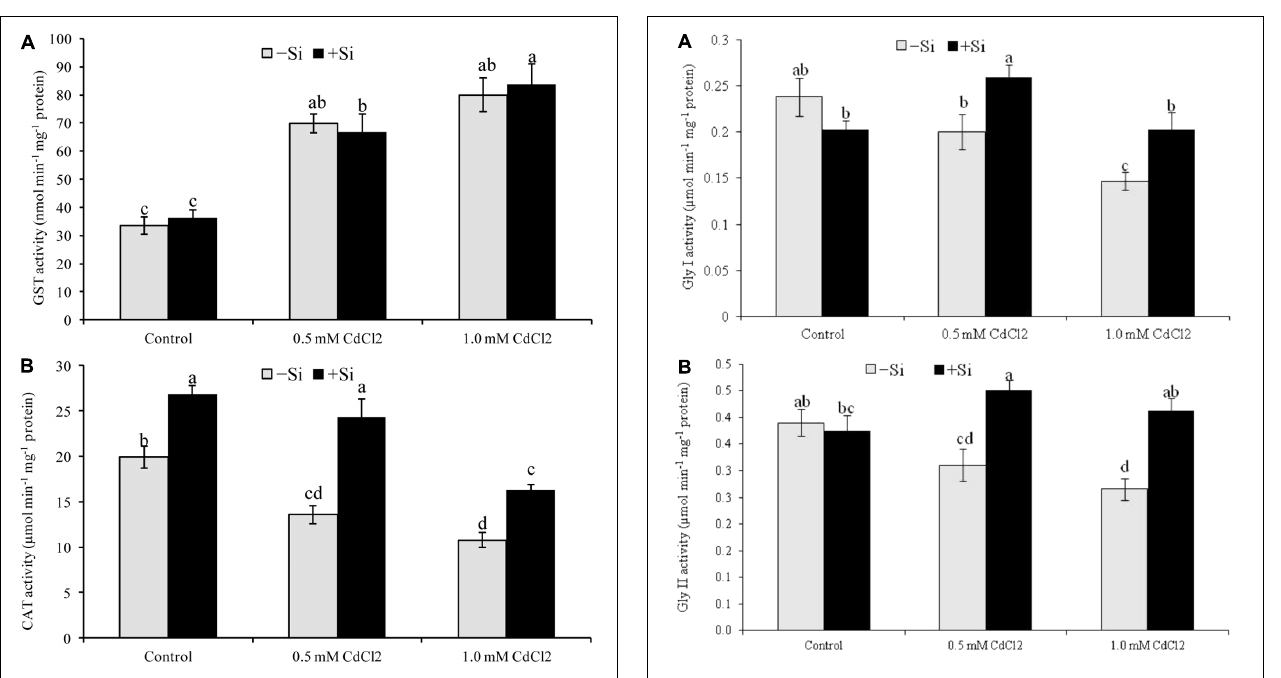
FIGURE 5 | Silicon-induced changes in the activities of glutathione S -transferase (GST) (A) and catalase (CAT) (B) in Brassica napus seedlings grown under Cd stress. Values (Mean ± SD) of each treatment are obtained from three replications. Bars with different letters are significantly different at P < 0.05 applying Tukey’s HSD test.